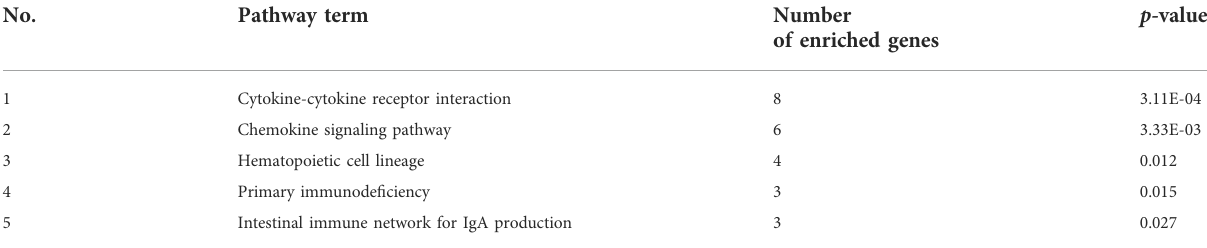
TABLE 1 The signi fi cantly enriched KEGG pathways of the differentially expressed genes (DEGs).